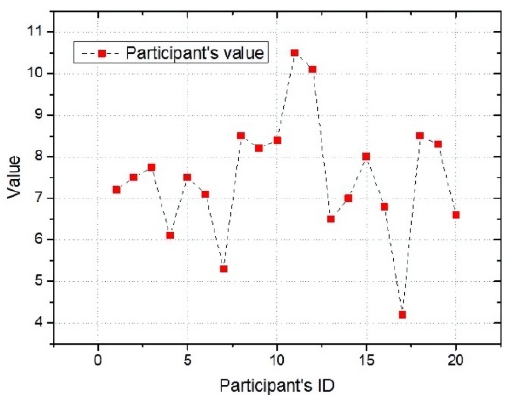
Figure 5. Participant value.